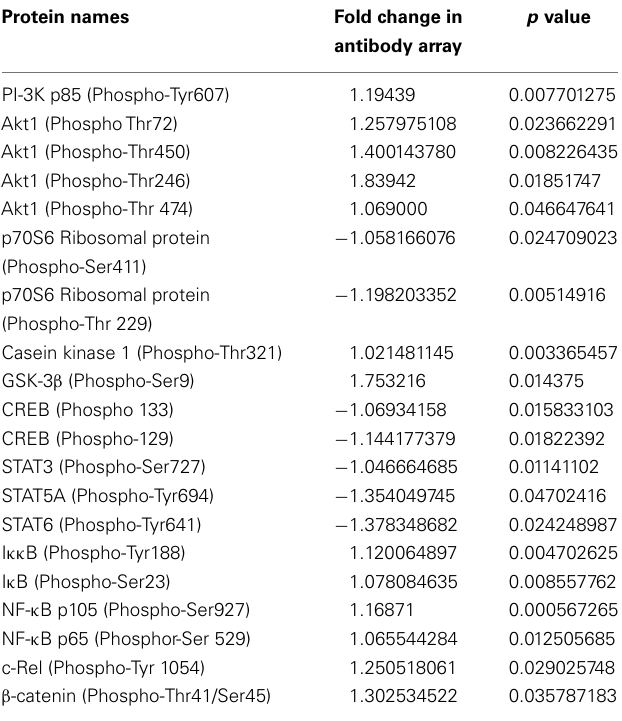
Table 2 |Antibody array